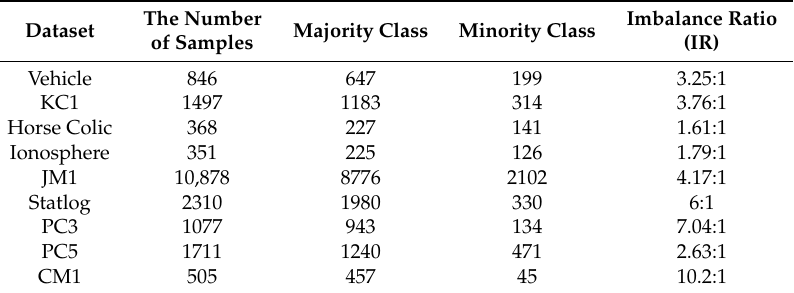
Table 2. Details of the Five Imbalanced Datasets.